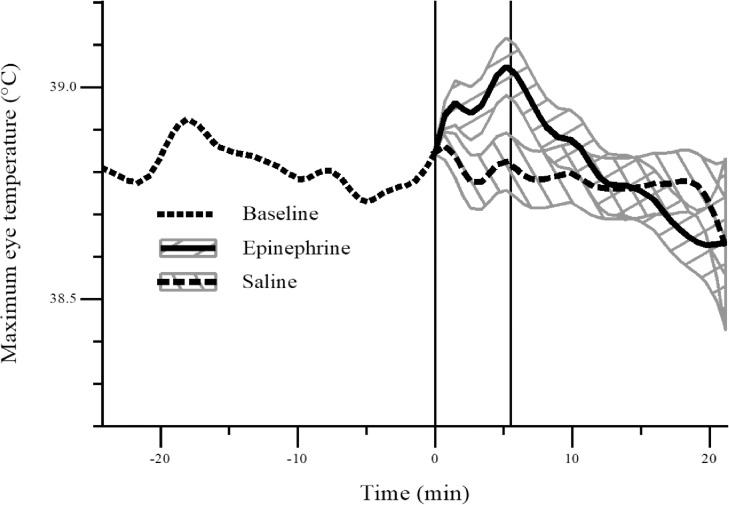
Average maximum eye temperature (°C) in sheep following an infusion (0 to 5 min) of epinephrine (n = 10) or saline (n = 10).The plot gives the estimated smooth curve at baseline (dotted), and for the epinephrine (solid) and saline (dashed) treatment groups post-baseline. The grey bands are Fisher's least significant differences between treatments. The two treatments are significantly different at the 5% level where the bands do not overlap. The left-hand and right-hand vertical lines denote the start and end of the infusion period, respectively.